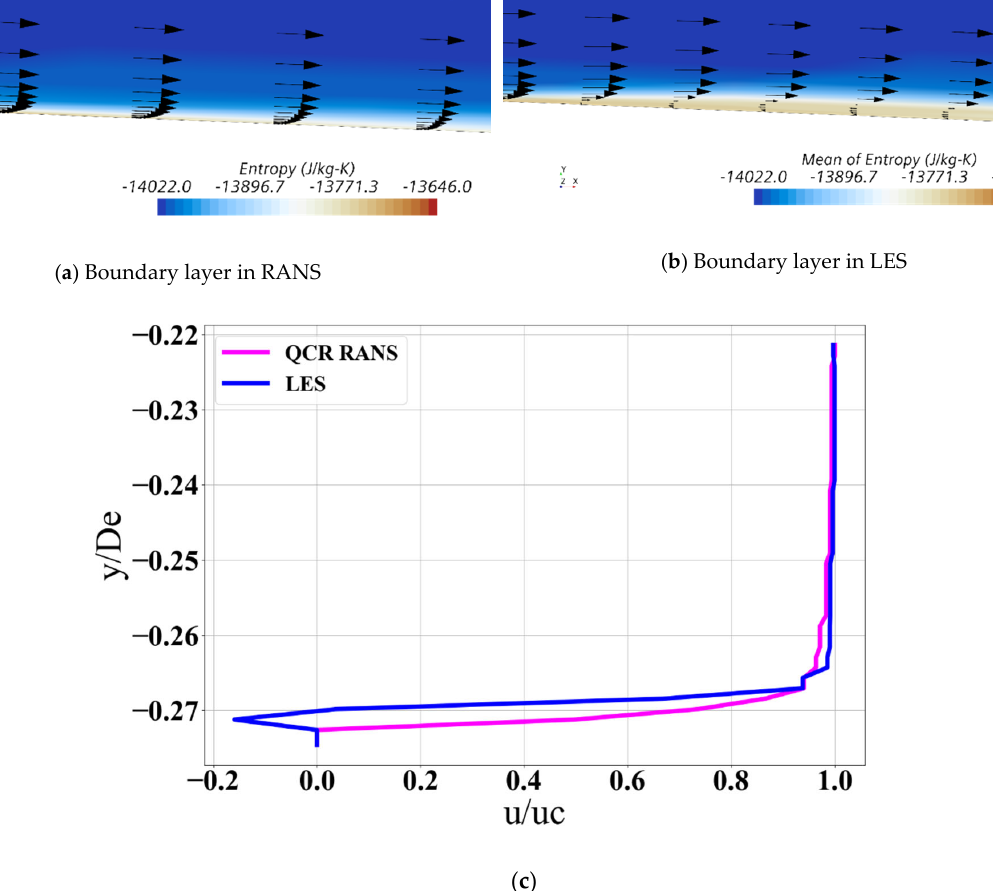
Figure 21. Boundary layer growth downstream of the nozzle throat, indicating ( a ) attached boundary layer in RANS, ( b ) separated boundary layer in LES, ( c ) Line plot at x/De = − 1, comparing RANS and LES.